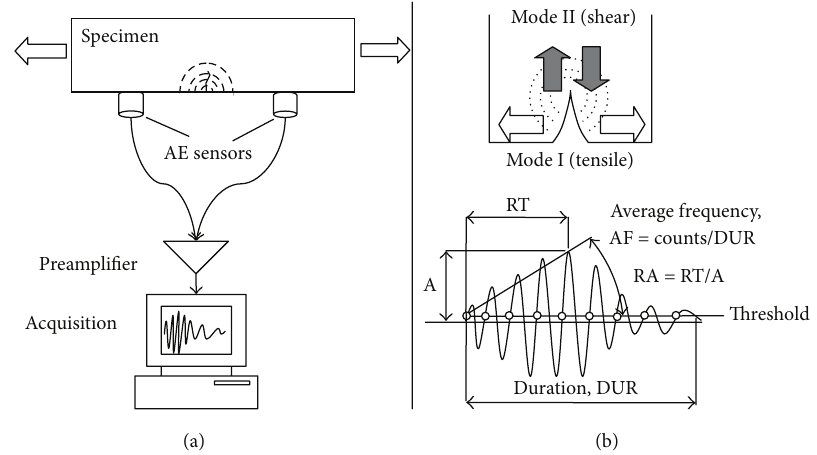
Figure 1: (a) Typical AE application in laboratory and (b) typical AE waveform and fracture